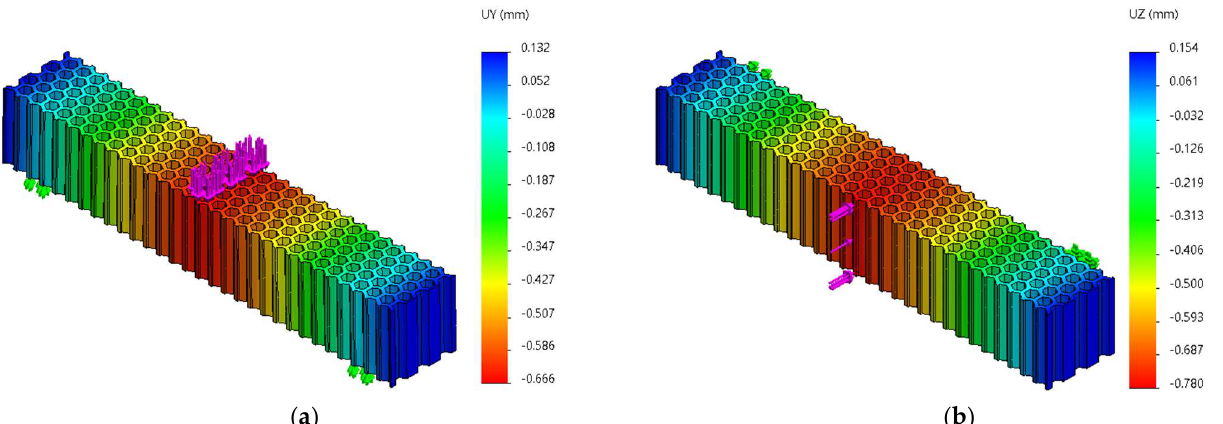
Figure 19. The Uy and Uz displacements charts obtained from FEM analysis of three-point bending of the hexagonal structure: ( a ) Fy = 70 N, ( b ) Fz = 70 N.